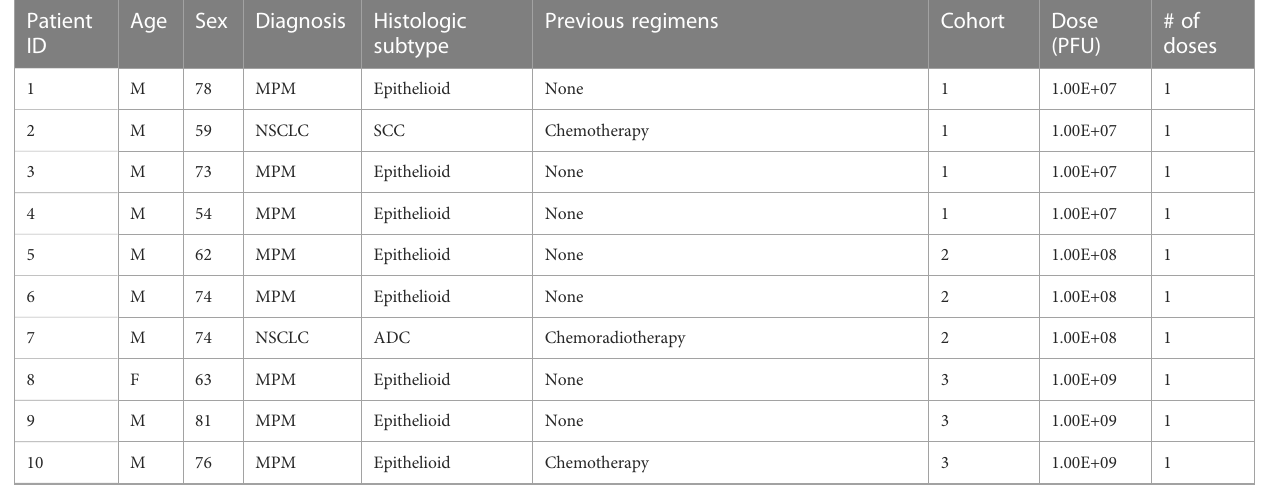
TABLE 1 Clinical characteristics of patients treated in the phase I